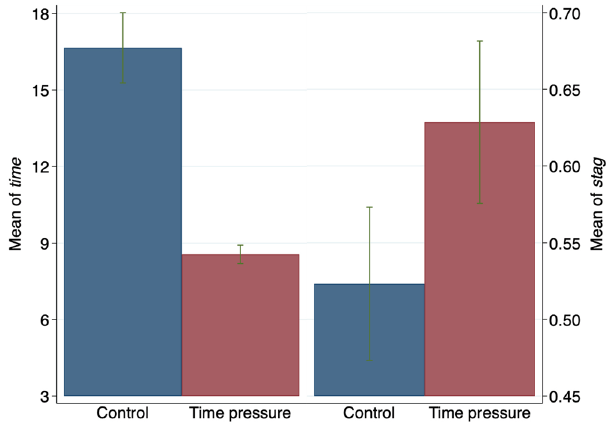
Figure 2. Average time in seconds for decision (left) and average play of stag (right), in control and time pressure treatments (confidence intervals at 95%). In both cases the two-sample t -test for mean equality rejects the null hypothesis at least at the 5% level of statistical